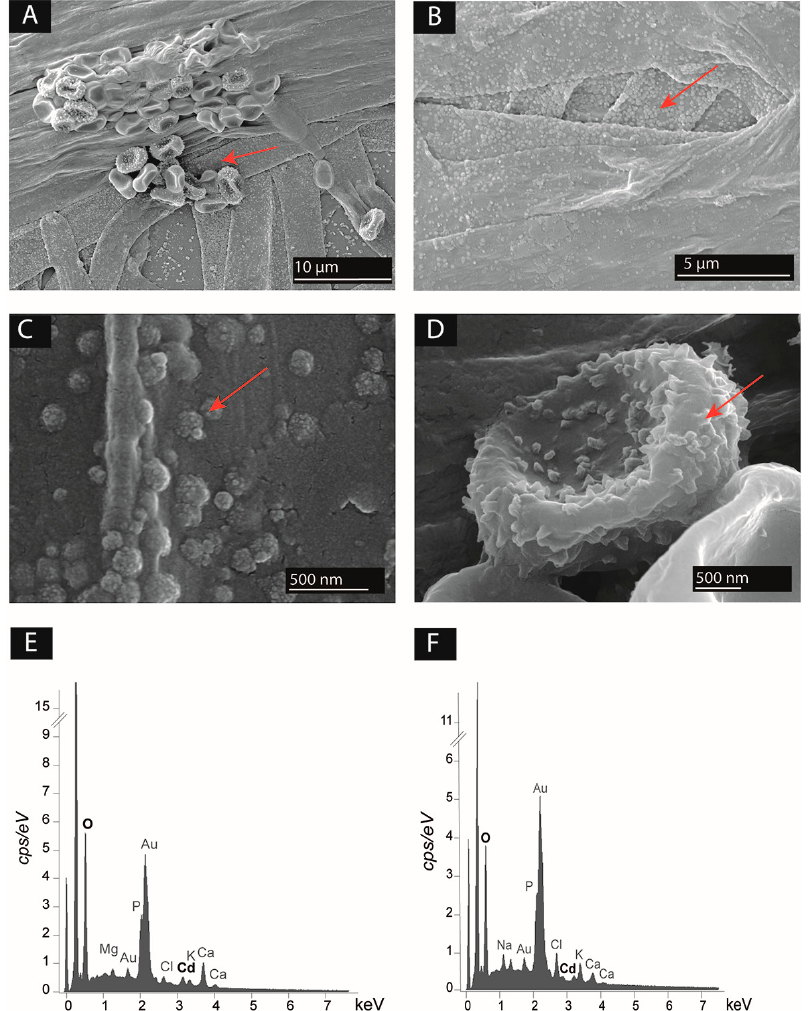
Figure 4. ( A – D ) Scanning electron microscopy (SEM) images showing the presence of particles associated to the surface of microbial biomass (red arrows) of ( A ) Trichoderma rossicum and Serratia ureilytica Lr 5/4 in co-culture in 0.5 mM Cd Angle medium; ( B ) T. rossicum in mono-culture in 0.5 mM Cd Angle medium; ( C ) close-up at the hyphal surface of T. rossicum in mono-culture in 0.5 mM Cd Angle medium; ( D ) close-up at the surface of Serratia ureilytica Lr 5/4 cells grown in 0.5 mM Cd Angle medium. ( E , F ) EDS spectra showing the elemental composition of ( E ) T. rossicum mycelium in mono-culture in 0.5 mM Cd Angle medium corresponding to image B; ( F ) the particles at the surface of the